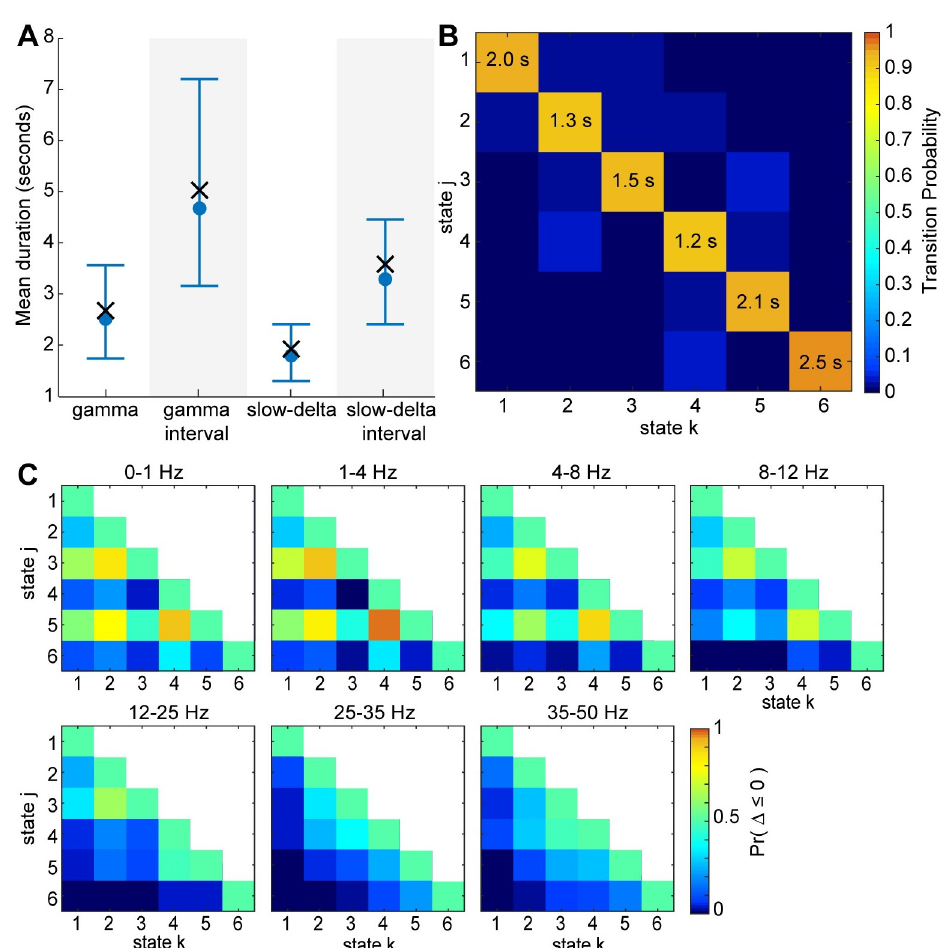
Fig 7. The estimated beta pdfs and transition matrix characterize the underlying dynamics of human scalp EEG under ketamine-induced general anesthesia. (A) Duration statistics corresponding to gamma and slow-delta activities. 4000 Markov sequences of length N = 2000 were simulated using the estimated transition matrix. The mean duration and interval corresponding to the gamma and slow-delta activities were calculated for each realization of these sequences. Median and 95% confidence bounds across all the simulated sequences are indicated in blue. The mean duration and interval calculated from the estimated state trajectory (output of the Viterbi algorithm which uses the maximum likelihood beta-HMM parameters and the observations as input) are indicated by a cross ( × ) symbol. (B) The transition matrices for NHP MJ and NHP LM with expected state duration (in seconds) indicated on the diagonal for all states. (C) Heatmaps indicating probability of the event that scaled power in state j is less than or equal to the scaled power in state k for 1 � k � j � 6 and for each of the 5 frequency bands. Note that the upper triangle (1 < j < k < 6), omitted to avoid redundancy, is equal to 1 minus the lower triangle (1 < k < j < 5). The color indicates Pr ( Δ � 0) which represents Pr ( X hj − X hk � 0), where X hj is a random variable characterized by state j ’s beta pdf in is a random variable characterized by state k ’s beta pdf in the same frequency band h frequency band h and X hk